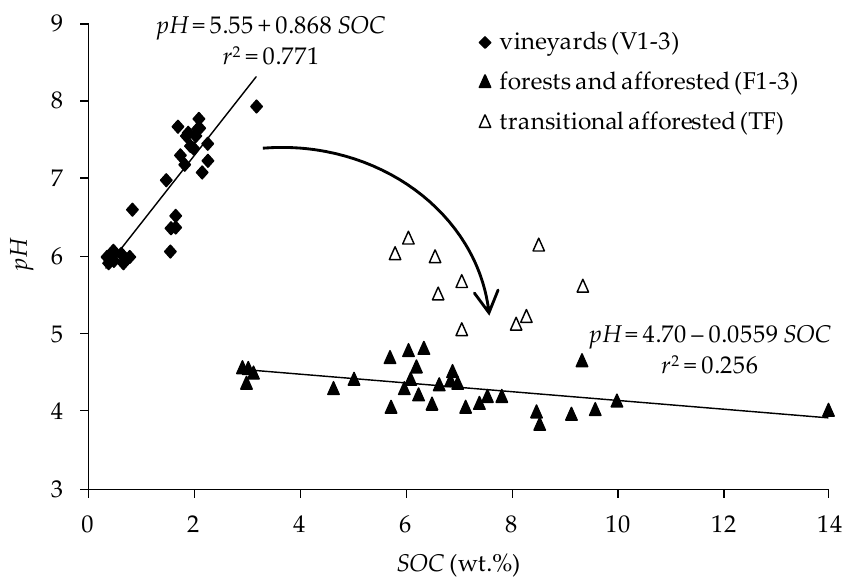
Figure 2. SOC content and soil pH relationships in samples collected from vineyards, forests, and afforested vineyards.